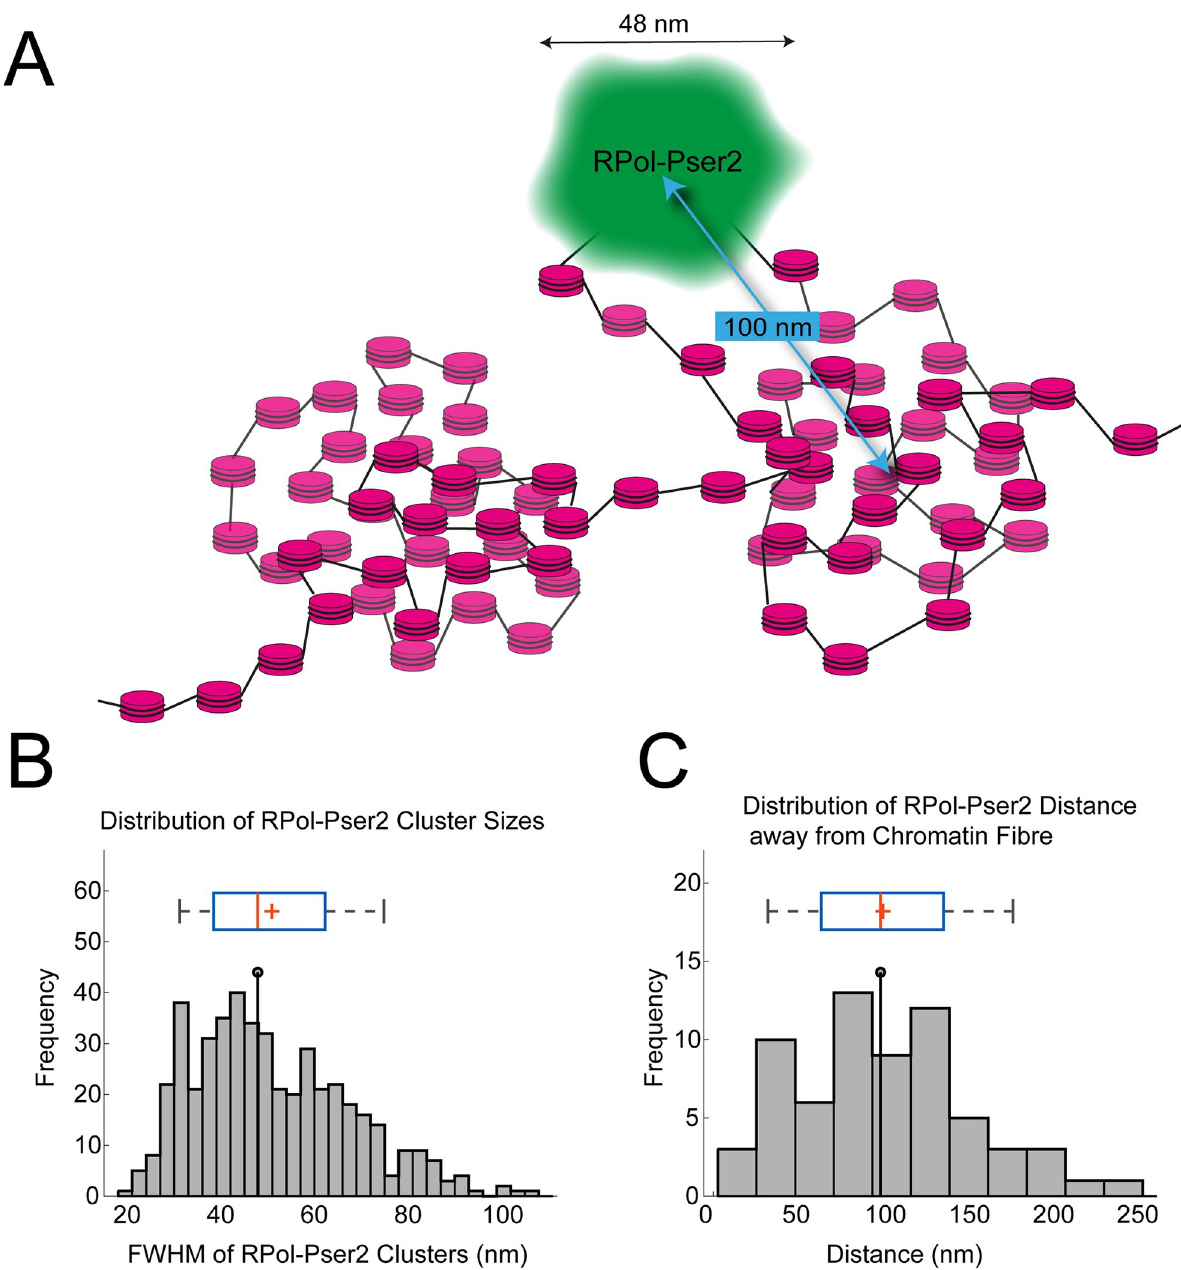
Fig 6. Quantification of association of Y loops to active transcription. (A) Schematic showing interpretation of an individual polymerase focus (green) on the periphery of a nucleosome cluster, on a decondensed small loop extending from nucleosome cluster. Arrows indicate average width of polymerase foci and distance from focus centre to centre of nucleosome cluster. (B) Histogram of FWHM of polymerase foci. The median width is 48nm. We note that the distribution appears biphasic or multiphasic suggesting the presence of multiple polymerases in each focus. (C) Histogram of distances between polymerase focus centre to centre of nucleosome cluster, mean is 100nm. The box and whisker plots are as in Fig 3. PSer2/PSer5 supports the above results (Fig 8), confirming that engaged RNA polymerase does not routinely occur in the cluster linking regions and also that the RNA polymerase loca- lisations are on the periphery of the chromatin clusters and displaced from the main axis of the Y loop chromatin fibres.